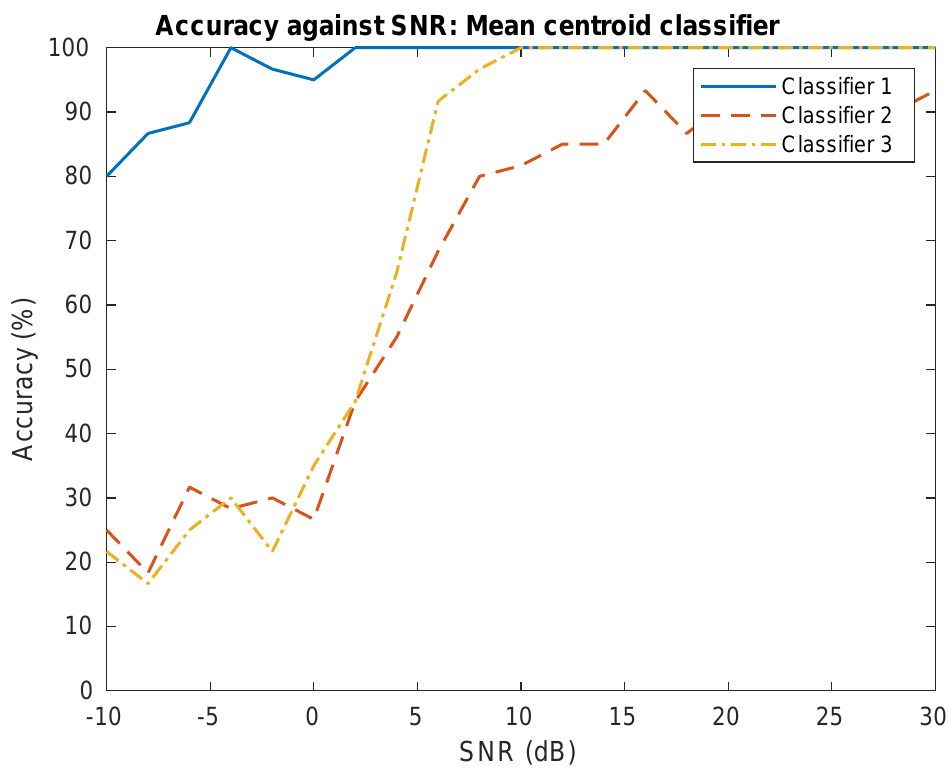
Figure 8. Performances evaluation on real-world